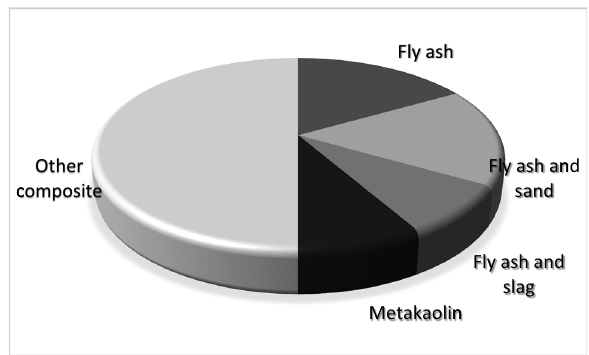
Figure 3: Research number percentage regarding the used